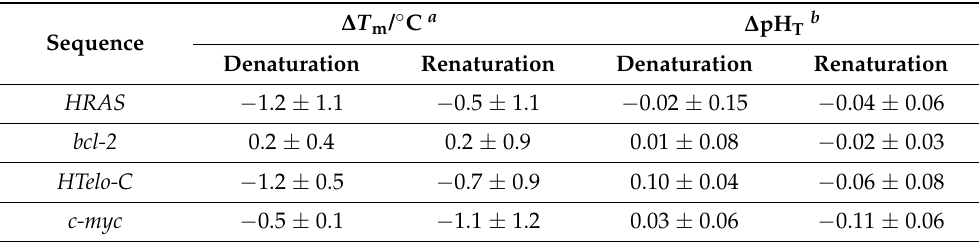
Table 2. Effect of IMC-48 on thermal ( ∆ T m ) and chemical ( ∆ pH T ) stability of i-DNA from CD- monitored denaturation